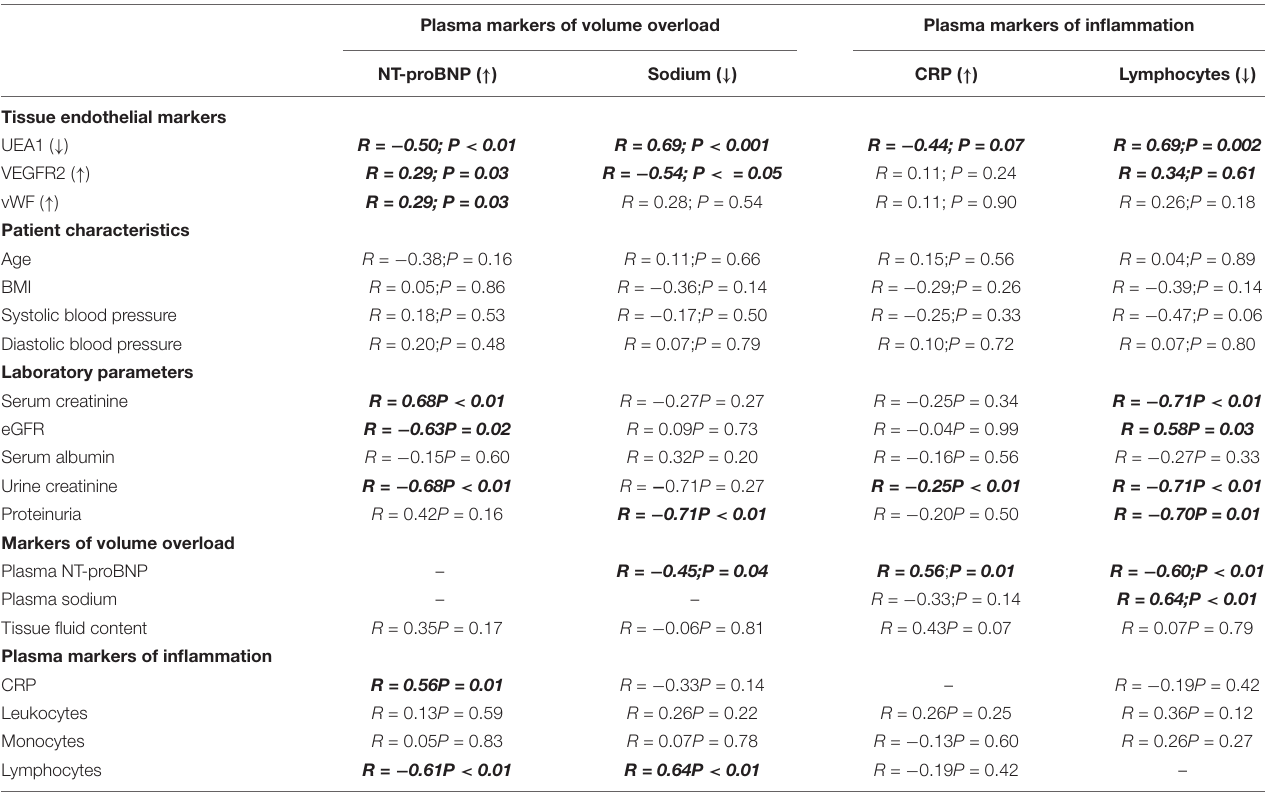
TABLE 2 | Linear regression analysis of quantified tissue endothelial markers and laboratory parameters with plasma markers for volume and inflammation. Plasma markers of volume overload Plasma markers of